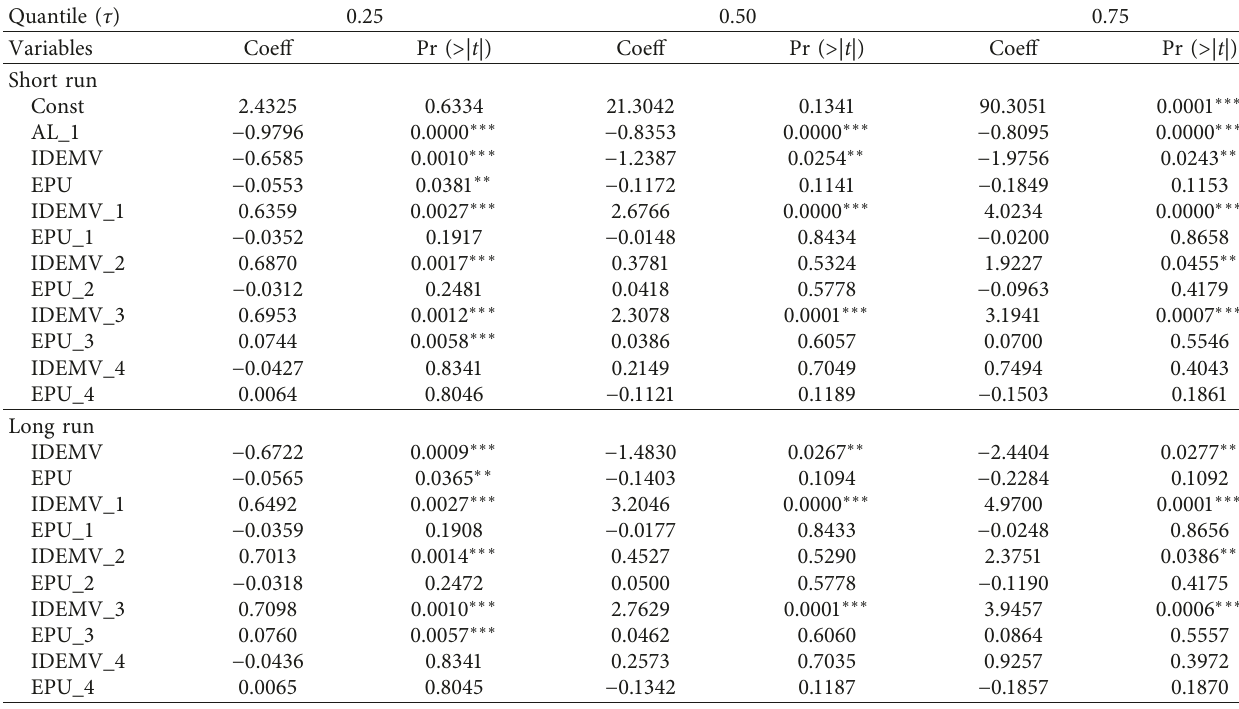
Table 13: QARDL estimation results: pandemic period (independent variables: EPU and IDEMV). Quantile ( τ